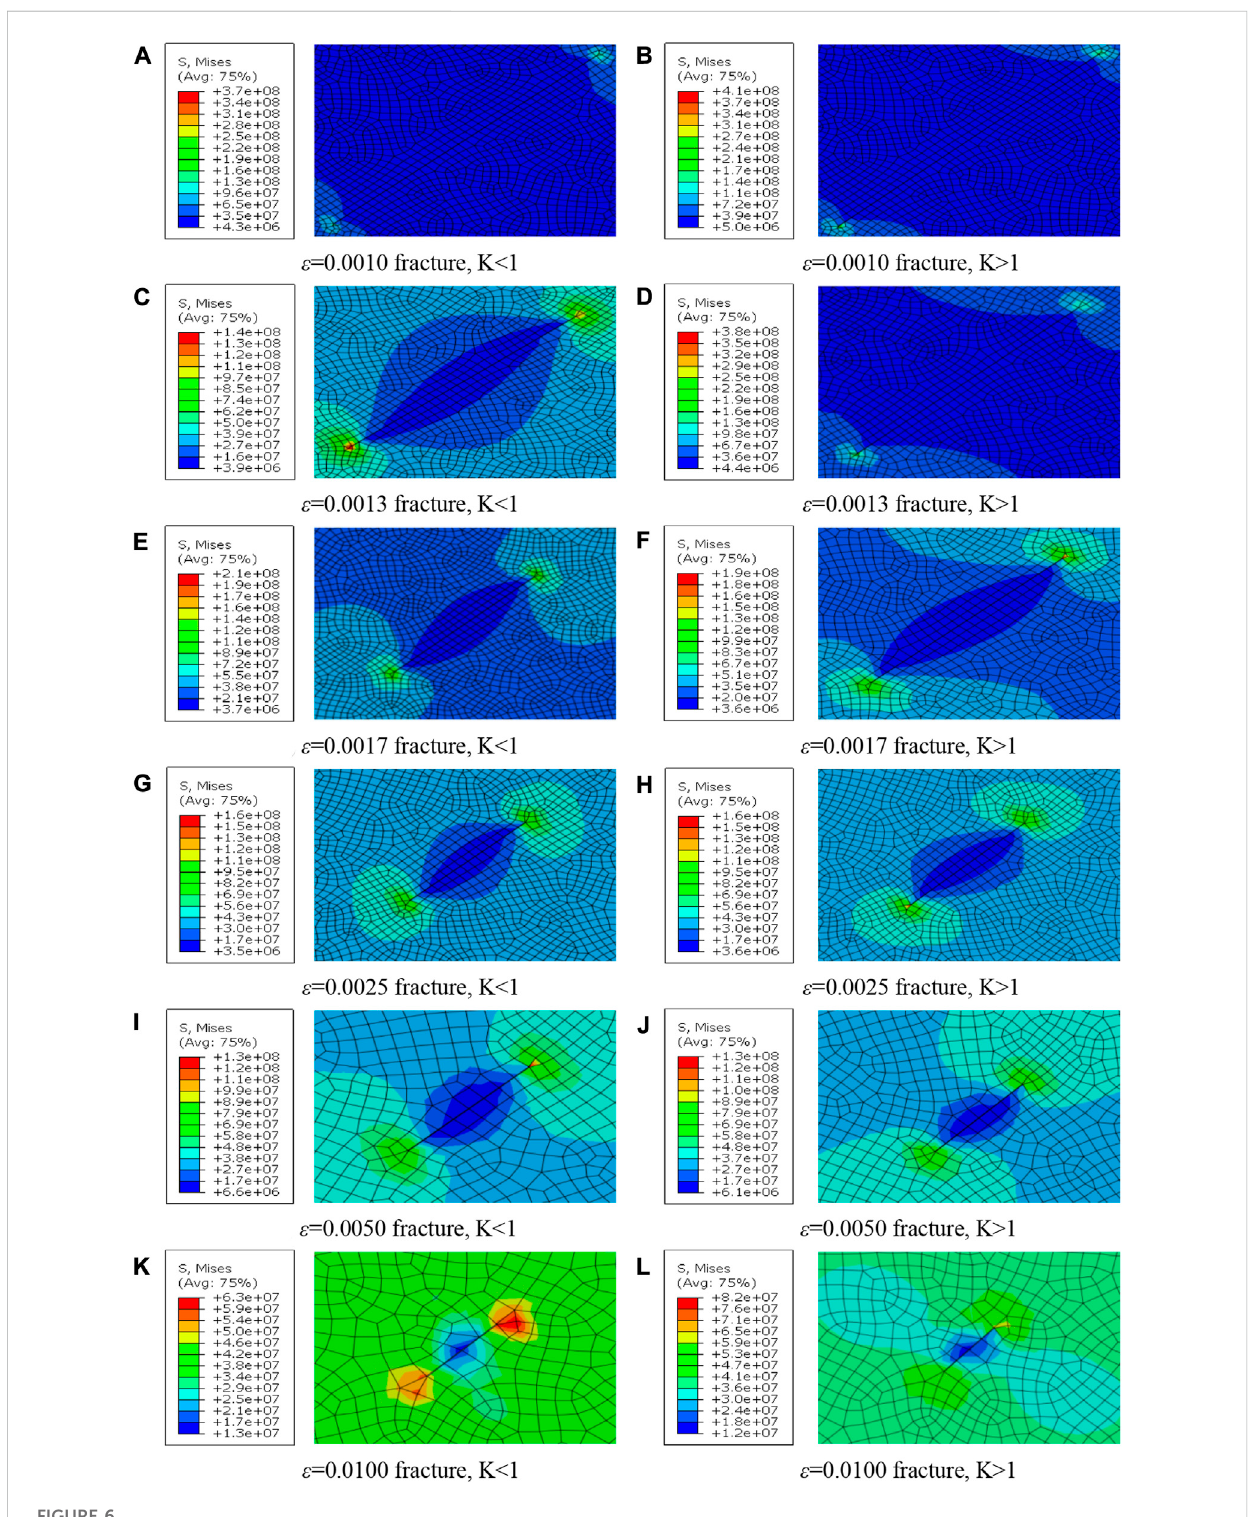
belongs to medium to severe damage, and increases with the increasing dip angle (Figure 5). The fracture with a greater dip dangle has more serious stress sensitivity